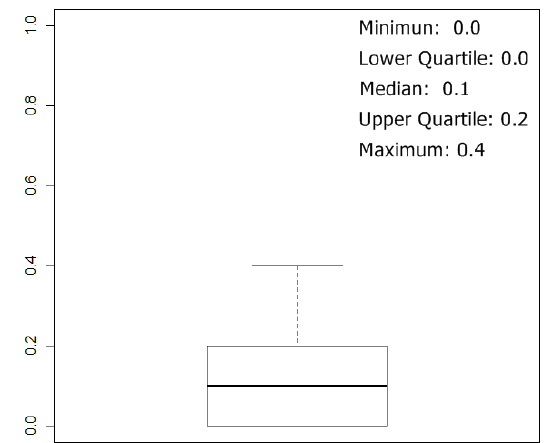
Figure 8. Boxplot of the error calculated over the test sets, considering the 50 simulations generated applying 10 rounds of 5-fold cross-validation over the 50